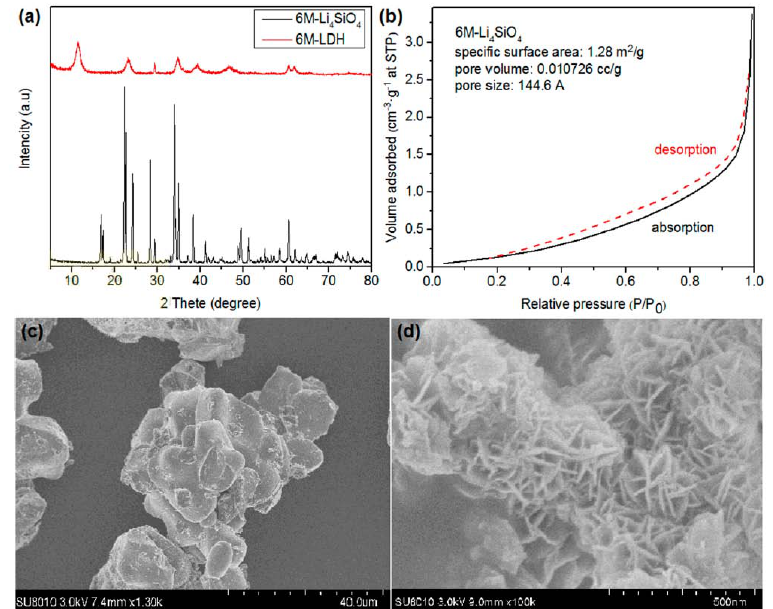
Figure 3. XRD, BET, and SEM analysis of synthesized Li 4 SiO 4 and Mg-Al-CO 3 LDH when 6 M aqua regia was used as the leaching acid, ( a ) XRD patterns of synthesized Li 4 SiO 4 and Mg-Al-CO 3 LDH, ( b ) BET analysis of synthesized Li 4 SiO 4 , ( c ) SEM image of the Li 4 SiO 4 sample, and ( d ) SEM image of the LDH